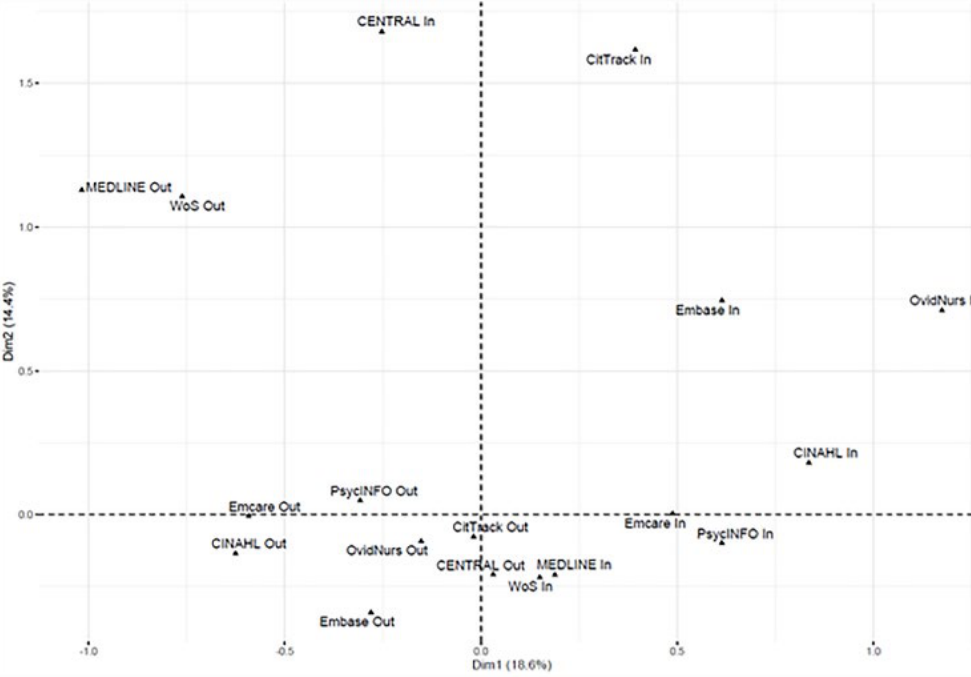
CT = Citation Tracking; WoS = Web of Science Core